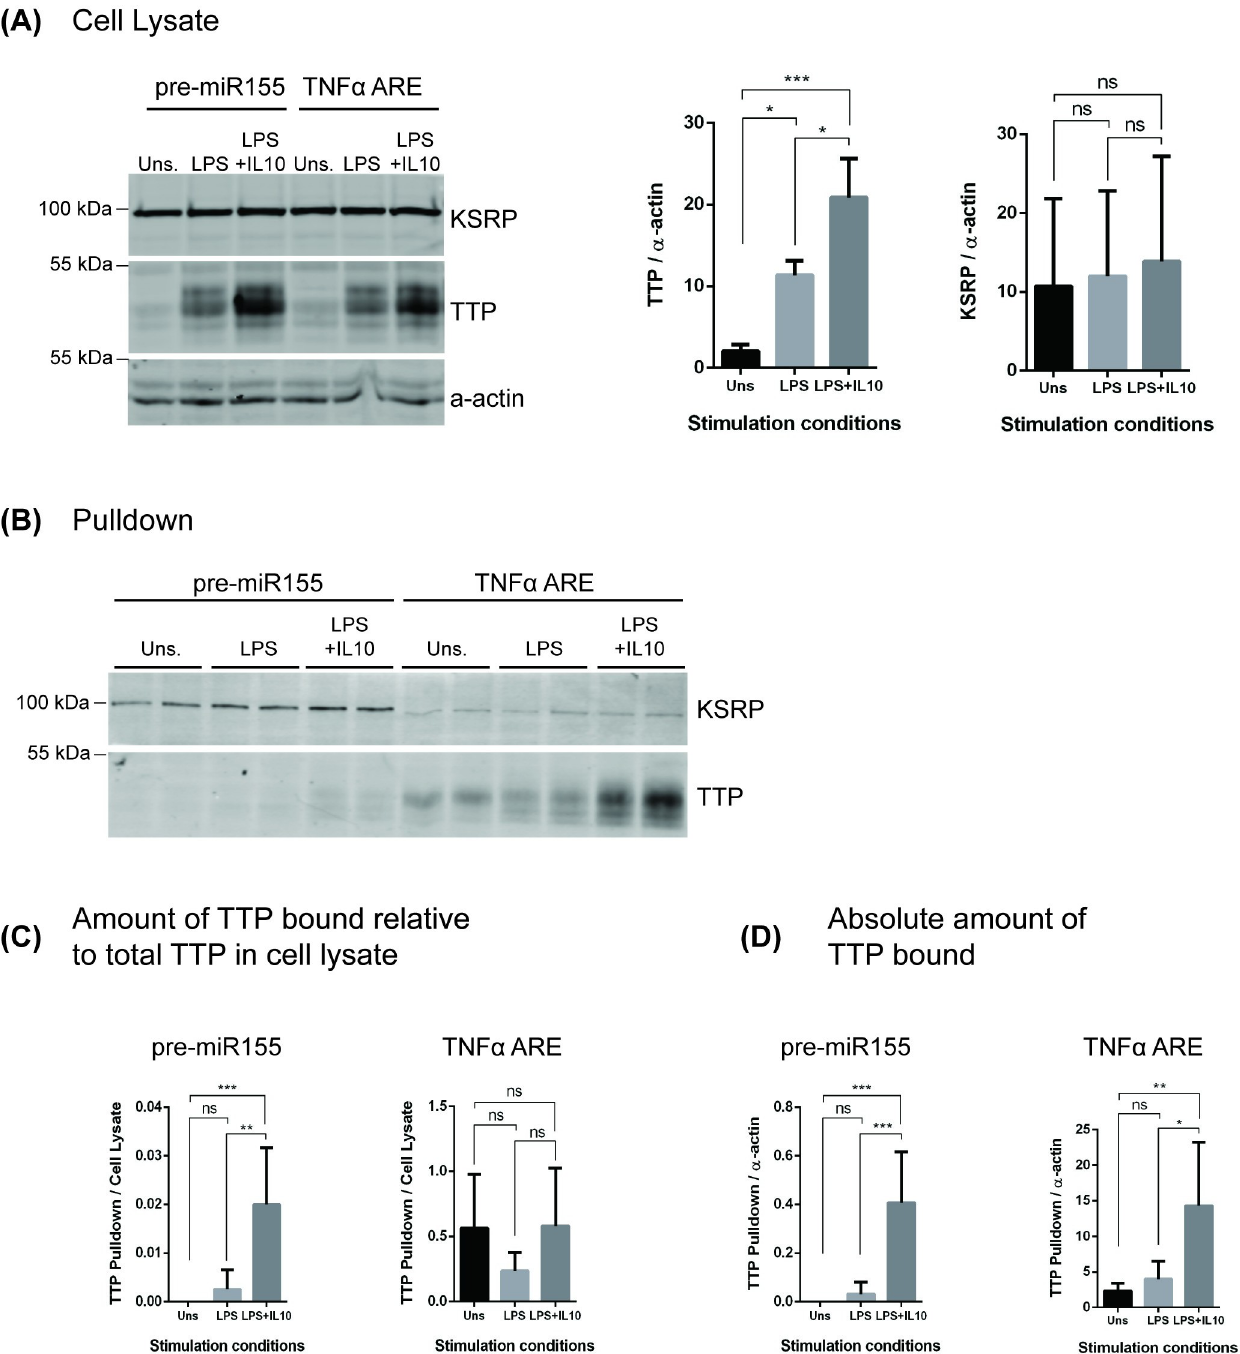
Fig 1. Validation of RNA pulldown technique by observing known TNF α ARE interaction proteins. RAW264.7 cells were transfected with indicated biotinylated RNA-oligonucleotides and stimulated with LPS or LPS + IL10 for 3 hours prior to collecting pulldown samples. Expression levels of proteins interacting with TNF α ARE or pre-miR155 oligonucleotides were determined by immunoblotting. (A) Immunoblot of cell lysate. Data plotted shows TTP and KSRP protein band intensities normalized to α -actin. (B) Immunoblot of the pulldown samples. Data plotted shows TTP protein band intensities for each pulldown normalized to either TTP protein (C) or α -actin (D) in total cell lysates. Data represents three independent experiments with significance between treatments calculated by One-Way ANOVA with Tukey’s correction, ��� p < 0.001, �� p < 0.01, � p < 0.05.